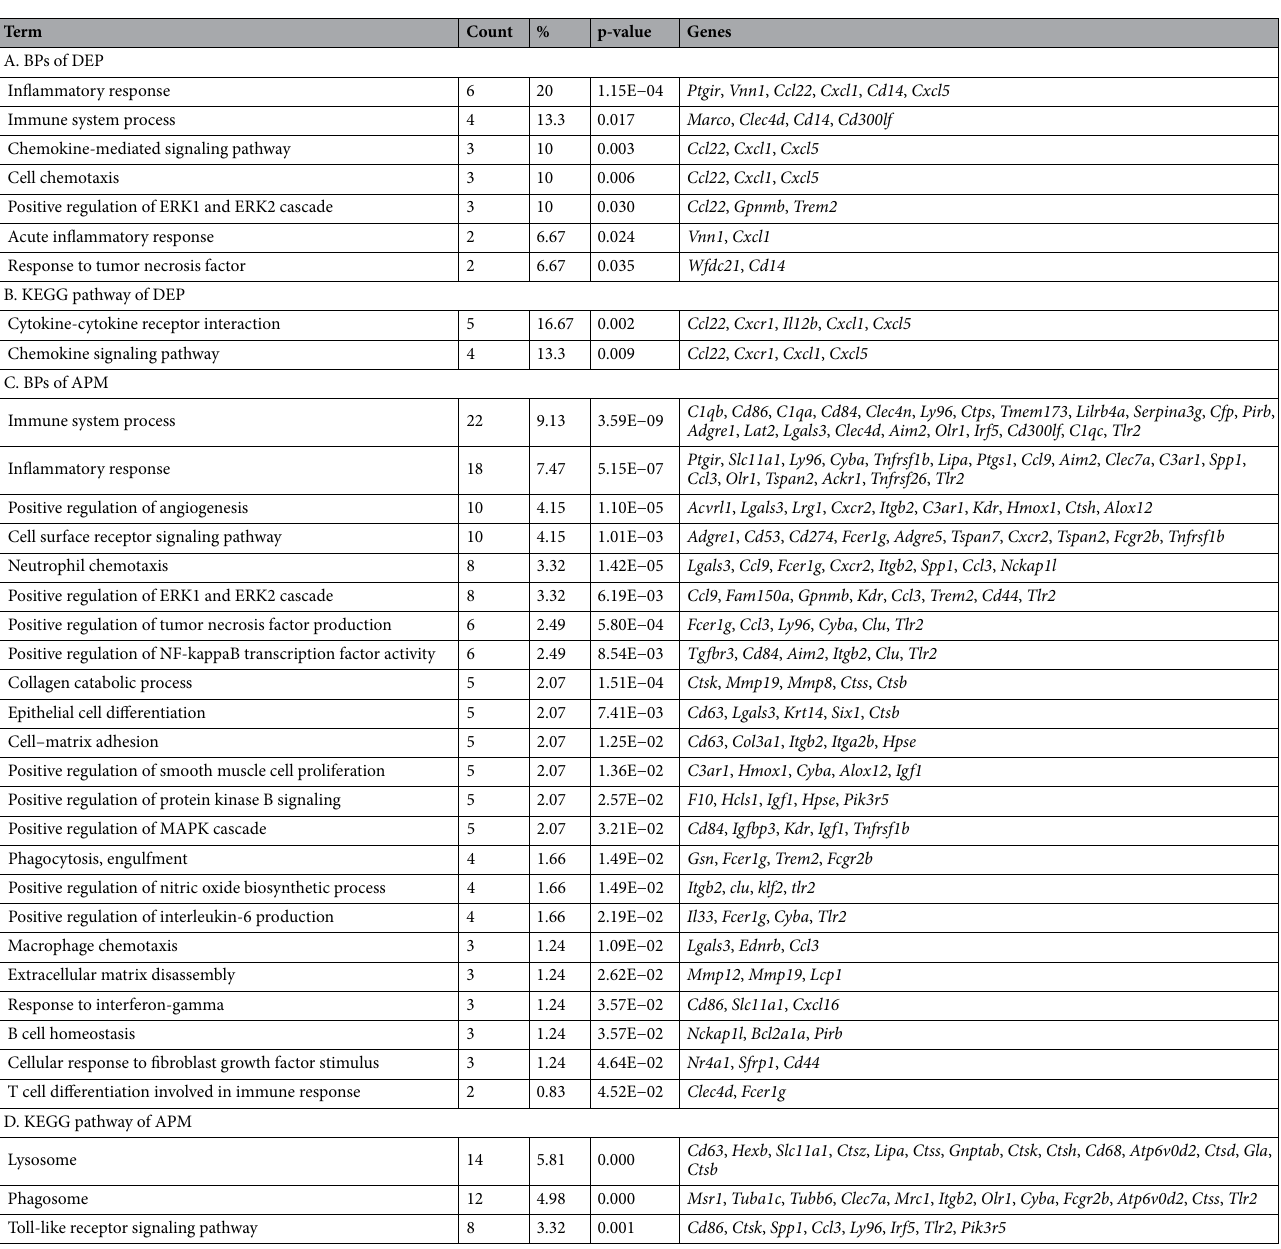
Table 2. GO functional category analysis of DEP- or APM-altered genes. GO Gene Ontology, DEP diesel particulate matter, APM artificial particulate matter, KEGG Kyoto Encyclopedia of Genes and